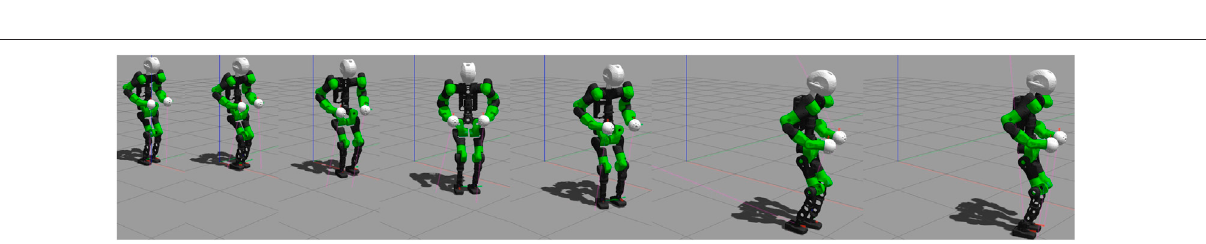
Frontiers in Robotics and AI |